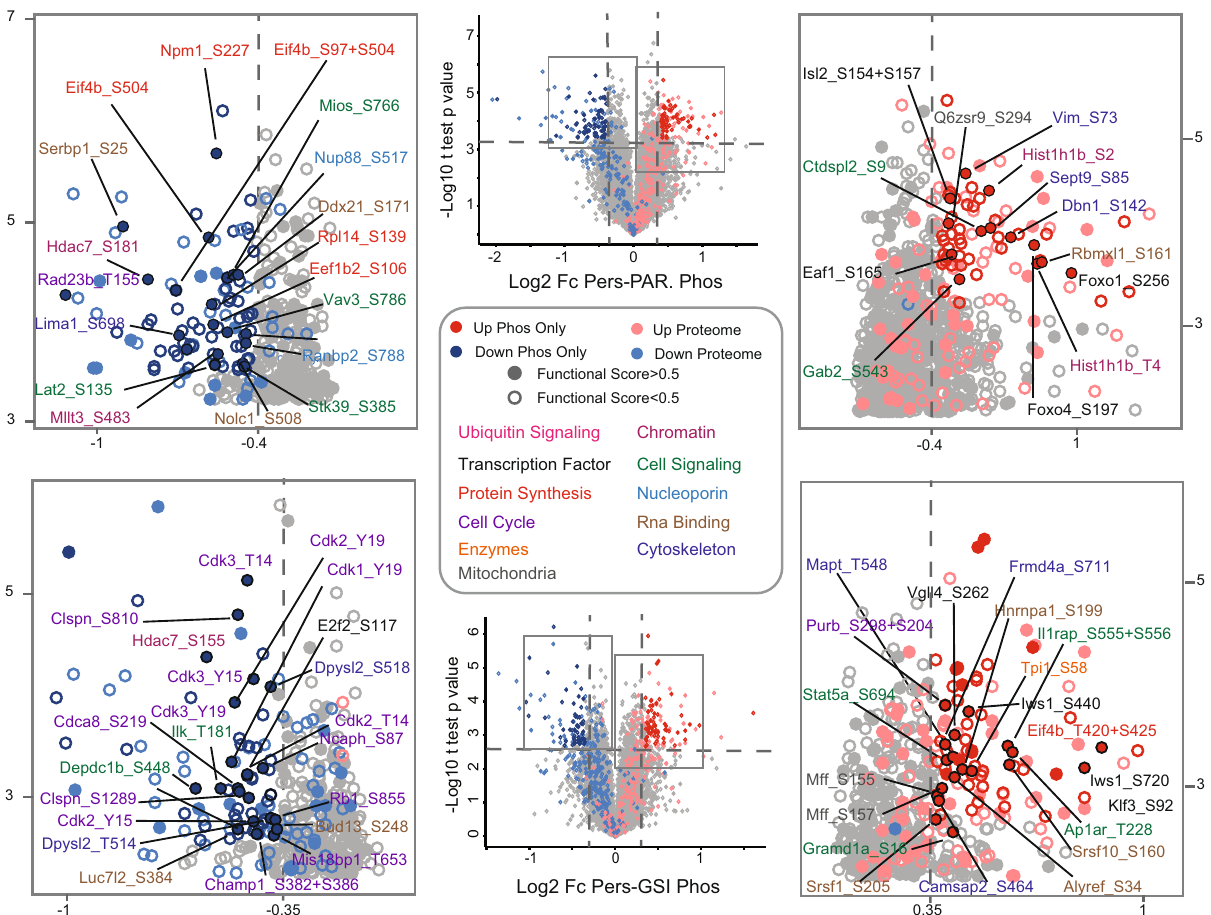
Fig. 4 Phosphoproteomics analysis of drug-tolerant persister DND-41 cells. Volcano plot analysis for the Persister/Parental (upper part) and Persister/ GSI (lower part) comparisons. Signi fi cance was determined through unpaired two-sided t test (Benjamini – Hochberg FDR < 0.01 for Persister/Parental and <0.05 for Persister/GSI; n = 3 biologically independent experiments). For signi fi cance analysis, a threshold on the Log2 fold-change was applied, equal to three times standard deviation, which was calculated on all sites, separately for up and downregulated ones. The annotated plots are magni fi ed sections of the volcano plots in the middle. Phosphosites whose corresponding proteins are regulated on the proteome level, using the same criteria applied to the phosphoproteome, are marked in pink (upregulated) and light blue (downregulated). Phosphosites with a functional score >0.5 are represented as fi lled circles. Only signi fi cantly regulated sites with functional scores >0.5 and not regulated on the proteome level are labeled. In the Pers/GSI comparison, shared regulated sites between comparisons are not labeled. The color name indicates the biological process the corresponding protein is